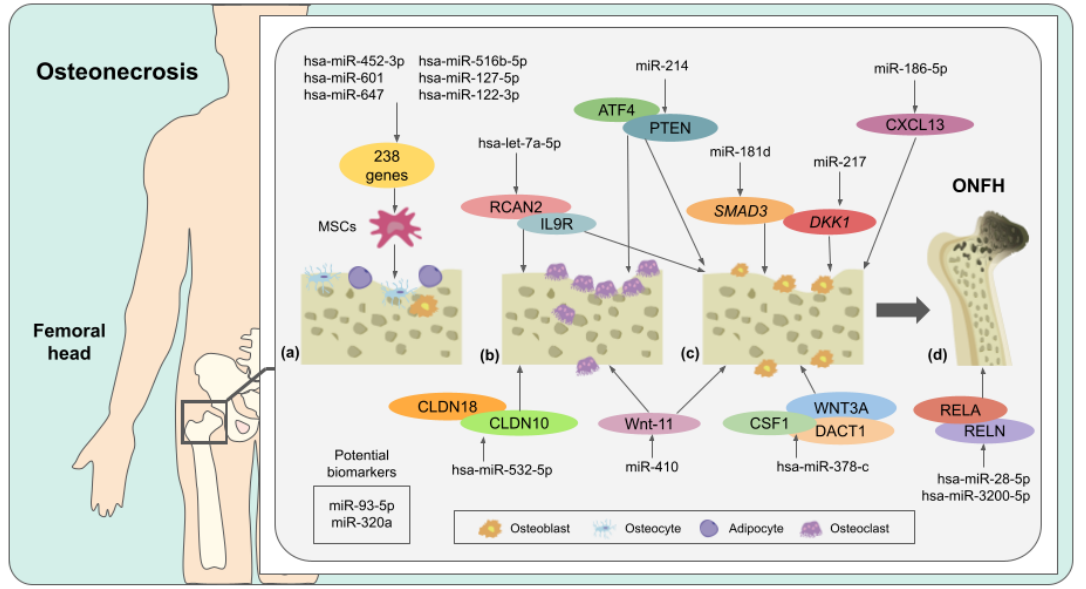
Figure 4. miRNAs and their respective targets (and functions) associated with the pathology of ONFH. Osteogenic and adipogenic differentiation ( a ), osteoclast proliferation ( b ), osteoblast proliferation ( c ), and cartilage degeneration ( d ) are the most representative roles of these miRNAs in ONFH. Remarkably, a number of these miRNAs represent potential biomarkers that might be used to diagnose this disease.